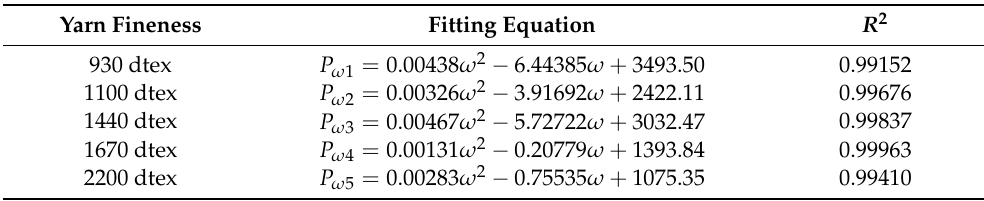
Table 2. Statistics table of fitting equation for twisting tension and spindle angular velocity under different yarn fineness.